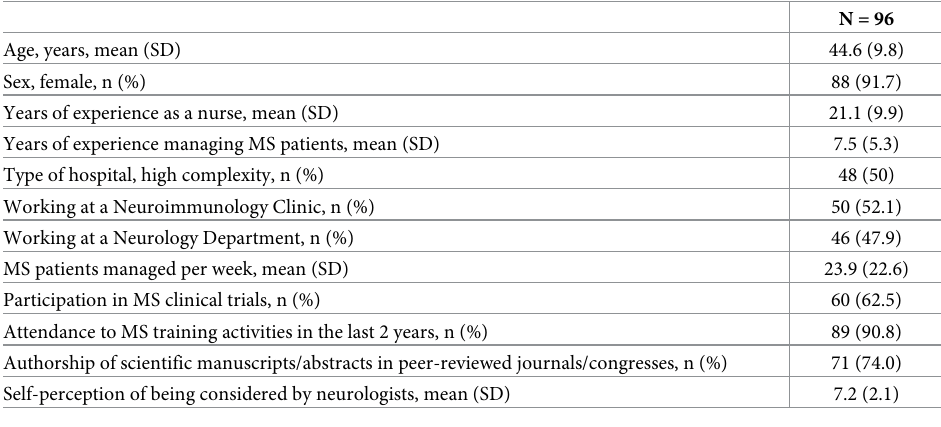
Table 1. Main characteristics of the